Question: What style of plot is this figure drawn as?
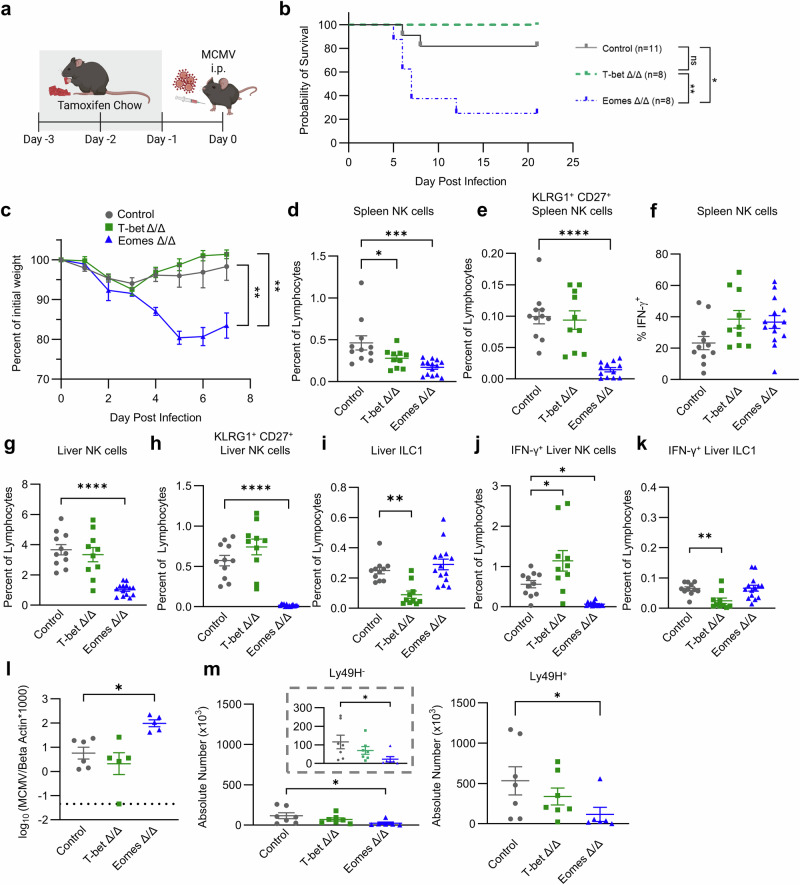
Answer: survival